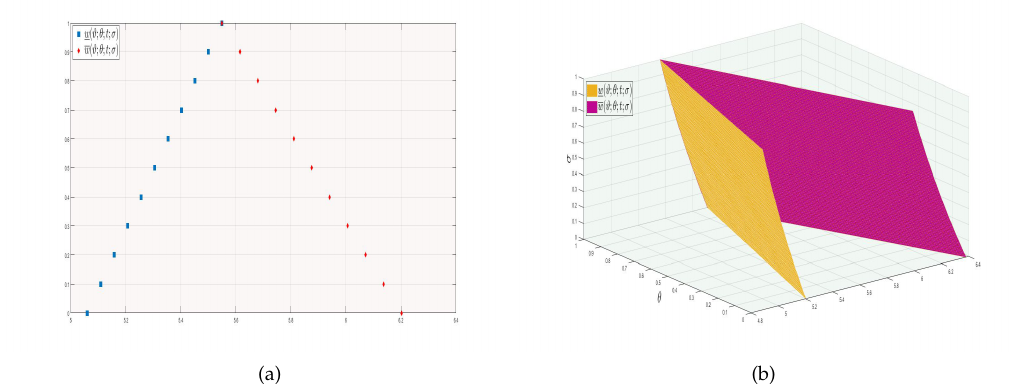
Figure 5. The exact lower and upper solutions of Equation (225) at ϑ = 0.1, θ = 0.4, φ = 0.9, t = 3, n = 1. ( a ) 2D figure for the exact solutions of fuzzy fractional ZK(3, 3, 3) equation of w in Example 9. ( b ) 3D figure for the exact solutions of w in Example